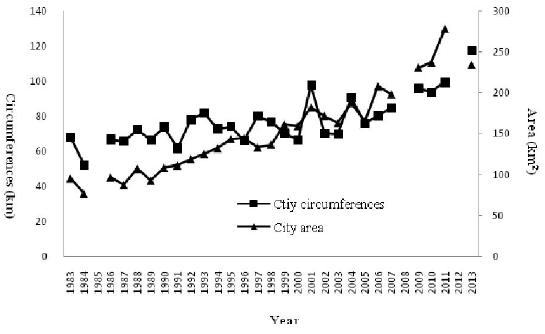
Fig ure.4 Temporal variation of city area and circumferences by Landsat TM between 1983 and 2013, Haidian District